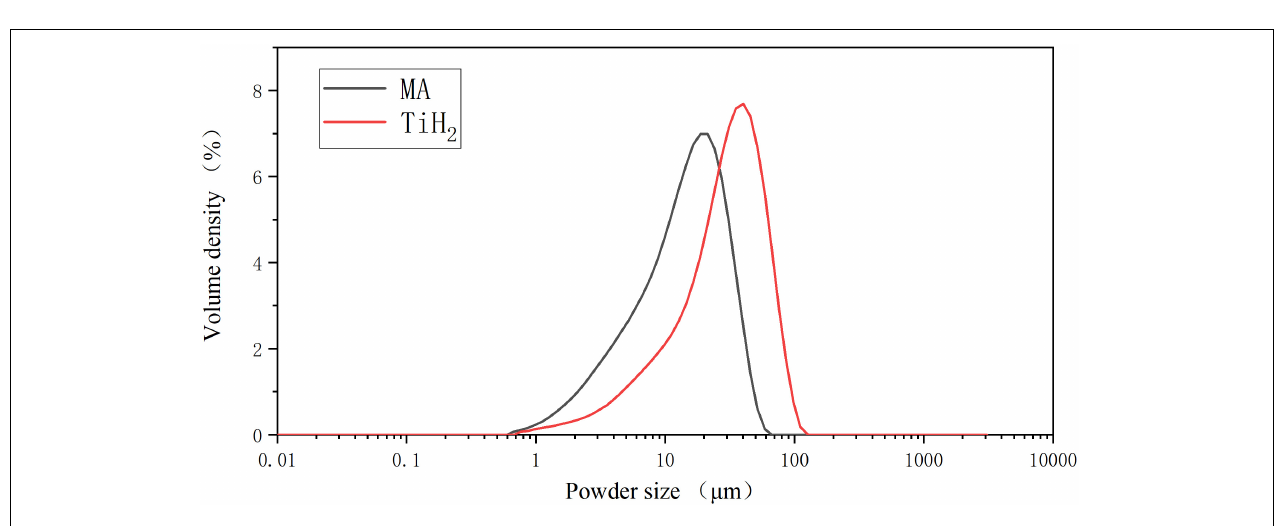
FIGURE 1 | SEM pictures showing the morphology of the starting powders of the selected sizes: (A) TiH2 and (B) 50%Al-25%Nb-16.7%Zr-8.3%Mo master alloy.